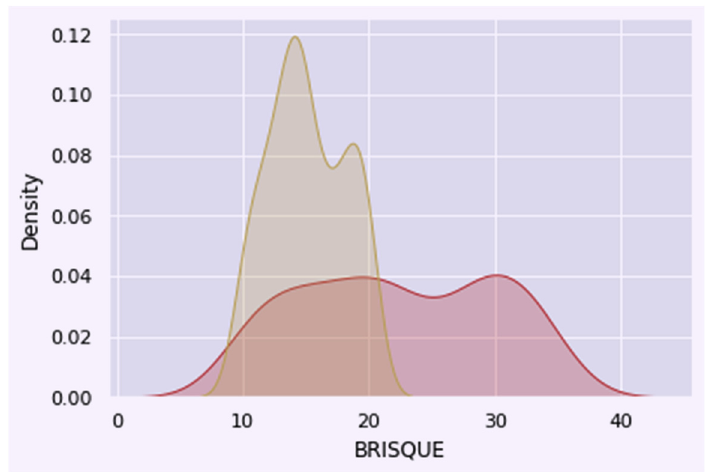
Figure 3. BRISQUE result on kinfaceW dataset generated